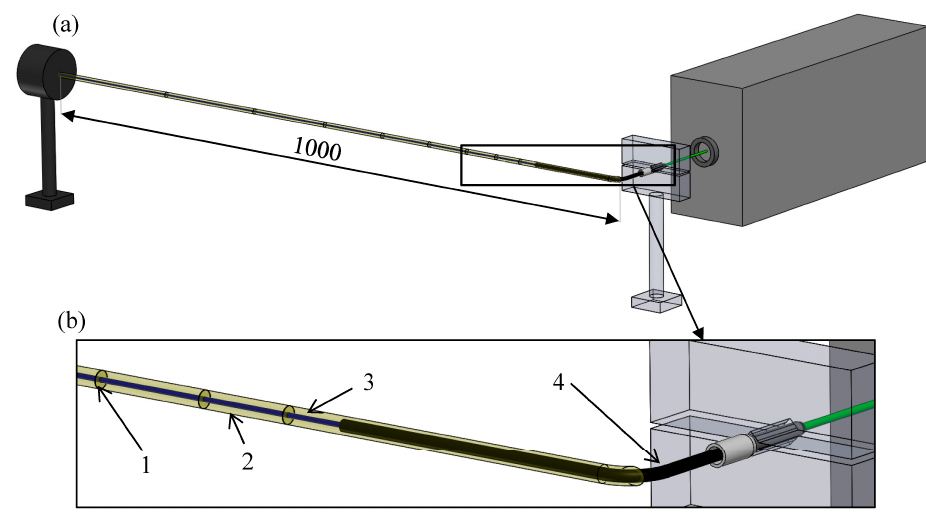
Figure 3. ( a ) Layout for measuring light transmission and ( b ) the specimen (1—measurement length marker, 2—resin, 3—glass fiber bundle, 4—shrink ‐ on tube).